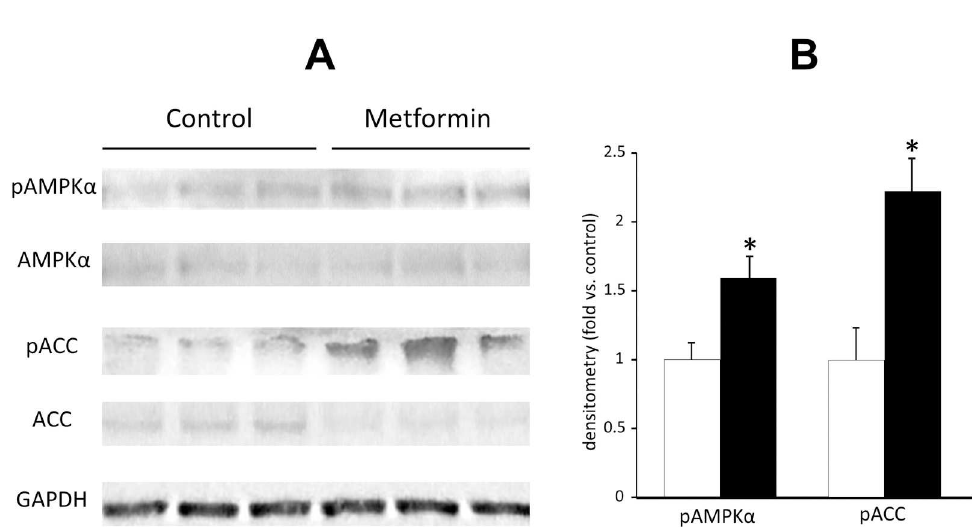
Fig 6. The protein expressions of pAMPK and pACC in the liver of SD rats at 15 weeks old.inhibo A; Western blot analysis, B; Densitometric quantification. Open bars denote control group and black bars denote metformin-treated group. Data are presentedas mean ± S.E. (n = 3 in each group). * P < 0.05vs. control groups.